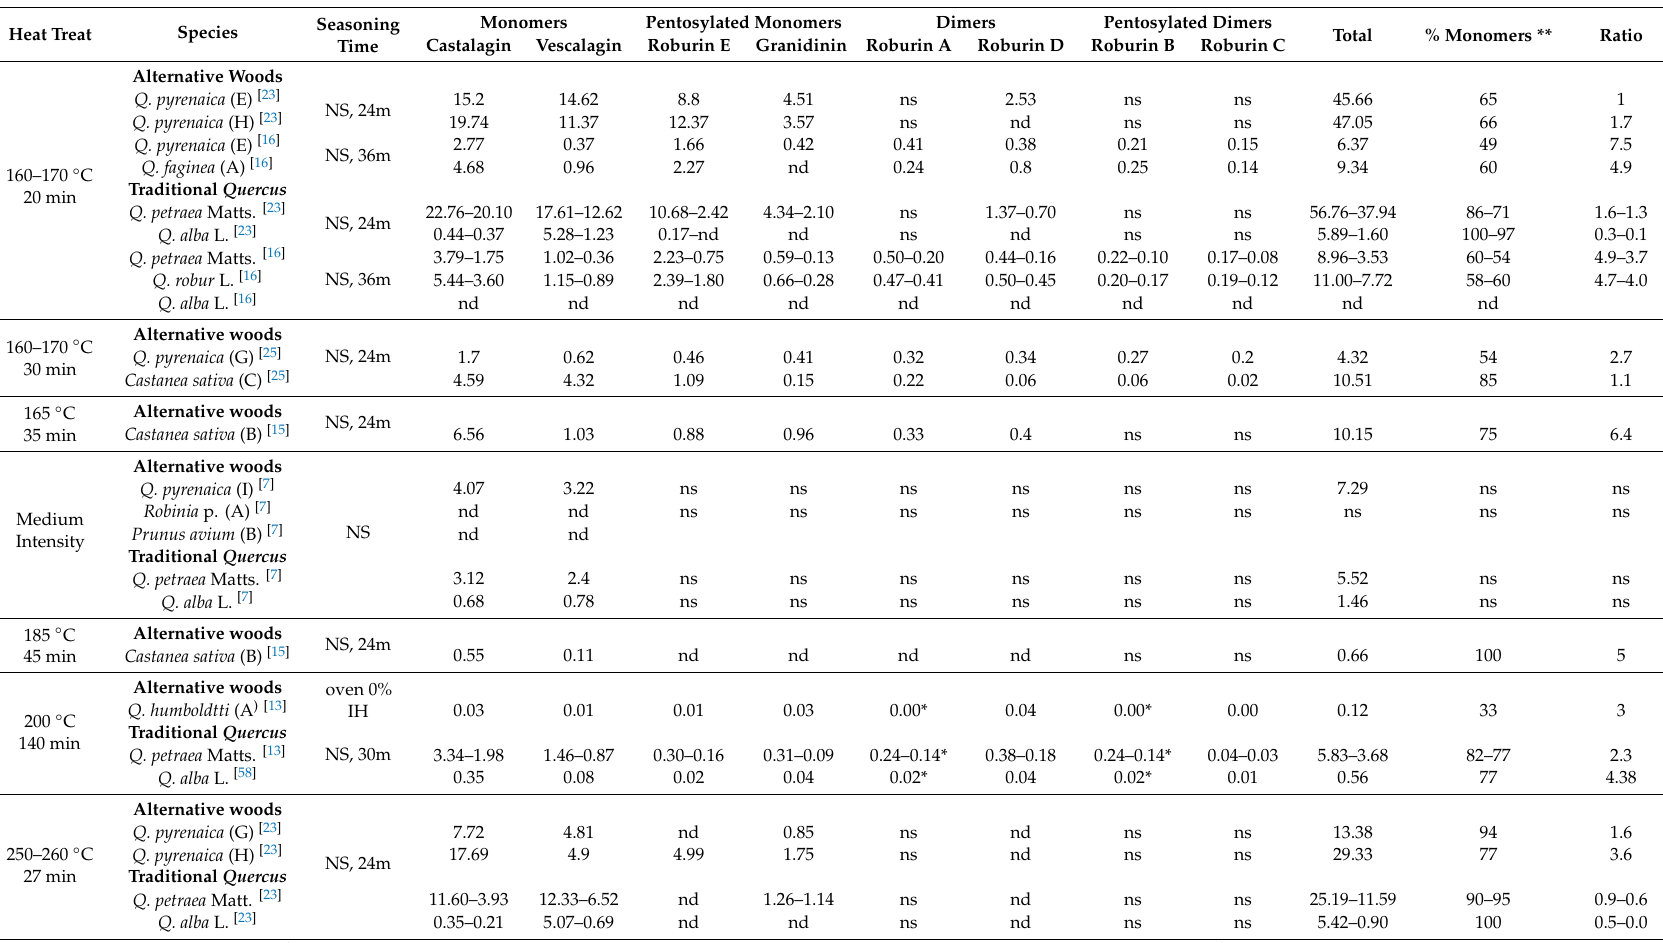
Table 4. Mean of the concentration expressed as mg / g of the ellagitannins found in woods of di ff erent botanical origin after